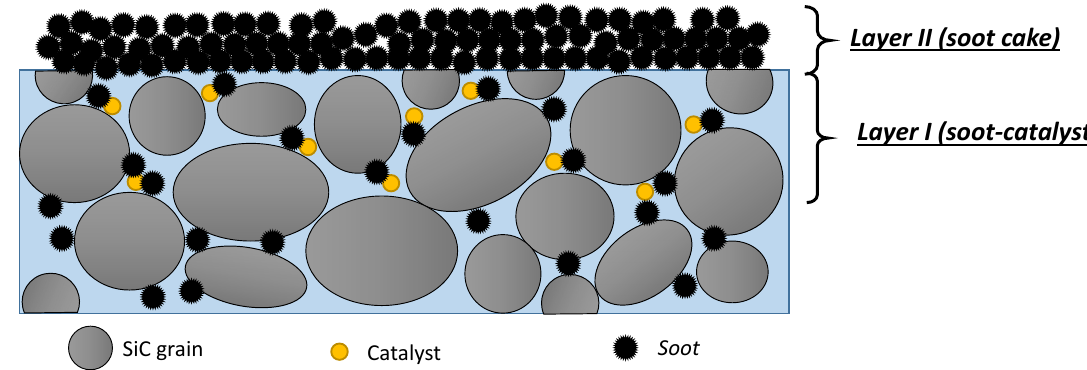
Figure 3. Schematic representation of the cross section of the wall of a catalytic DPF showing two layers with different soot-catalyst contact conditions: Layer I—soot in contact with the catalyst dispersed inside the DPF macro-pores; Layer II—soot cake accumulated on top of the wall in poor contact with the catalyst. Adapted from [14].